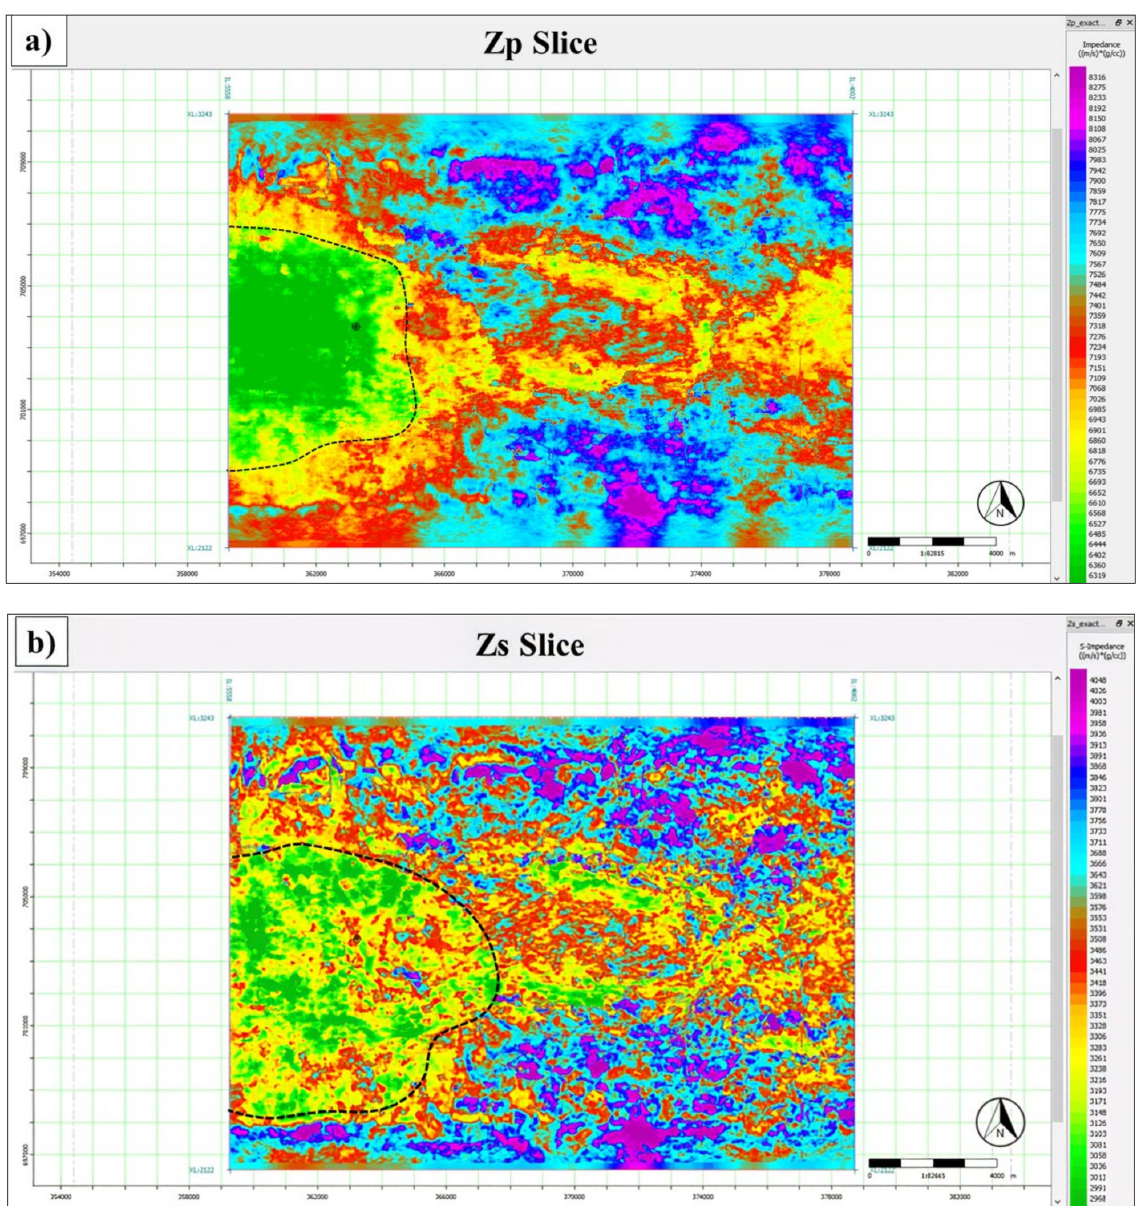
Figure 19. ( a ) Averaged Zp data horizon slice within interval between Top H and H60 horizons; ( b ) Averaged Zs data horizon slice within interval between Top H and H60